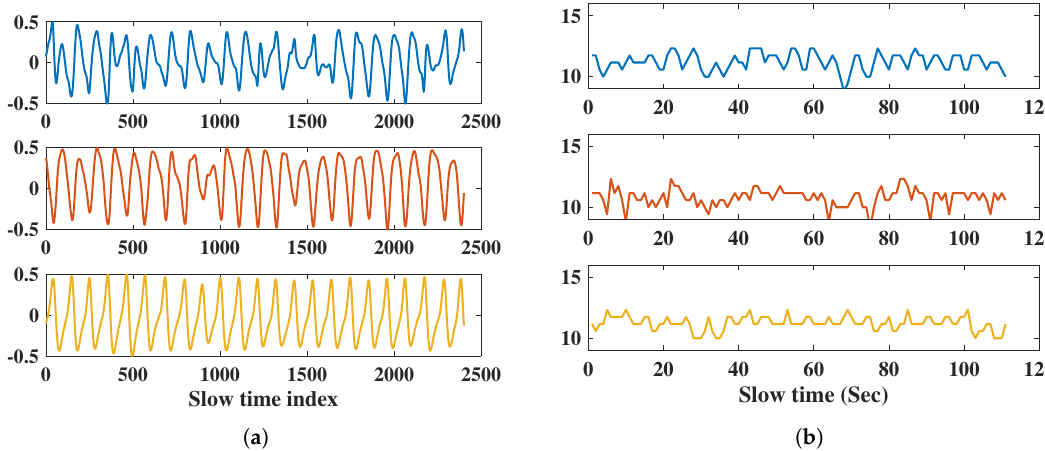
Figure 12. RR Measurement results of front side; ( a ) respiration signal in the time domain with IR-UWB, FMCW, and reference belt, ( b ) respiration rate of 110 s with IR-UWB, FMCW, and reference belt. Table 10. RMSE results of radar measurements for each orientation. RMSE Front Left (90 ◦ ) Right (90 ◦